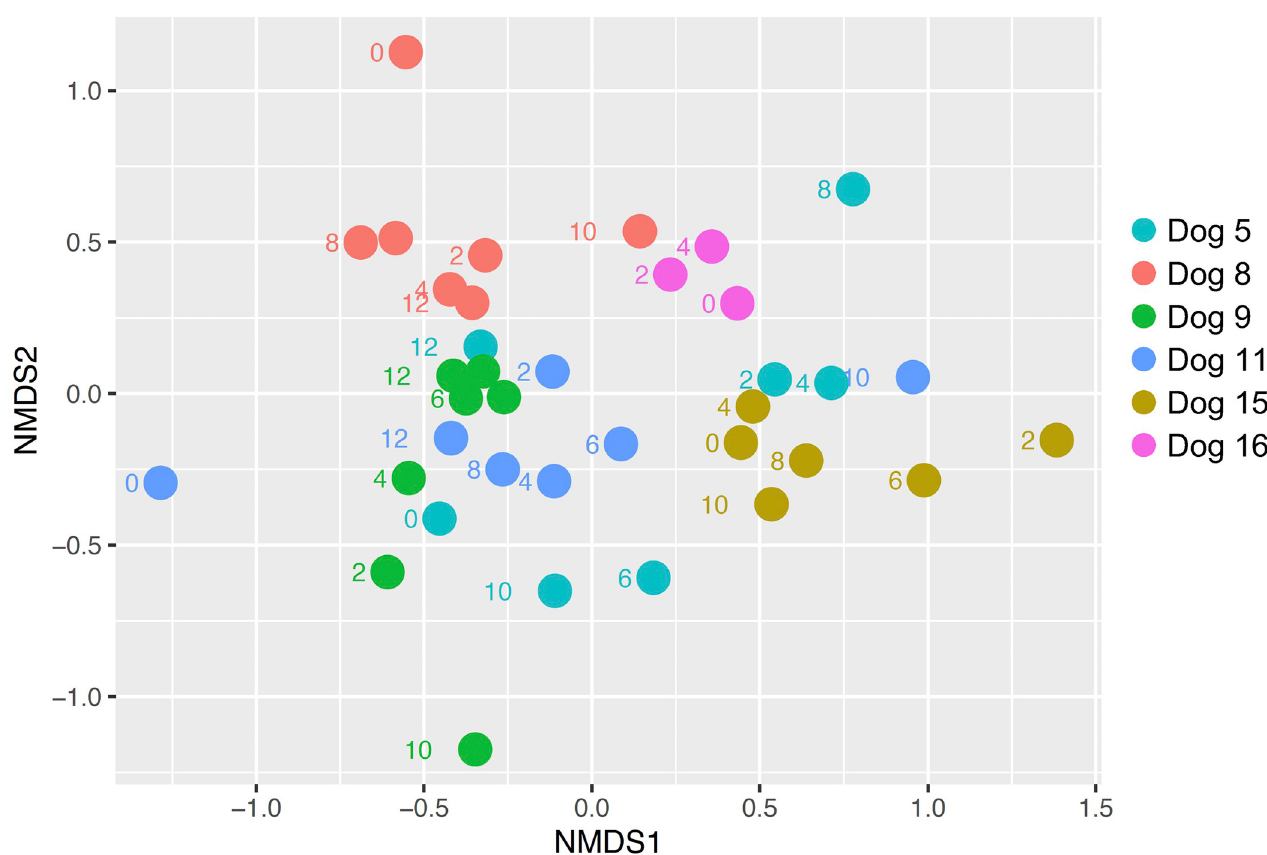
Fig 4. Beta diversity analysis. Non-metric multi-dimensional scaling of the Bray-Curtis dissimilarity index. Numbers next to each circle represent the week of sampling. The major source of variation among samples was the individual dogs (R 2 = 0.46; P = 0.01).